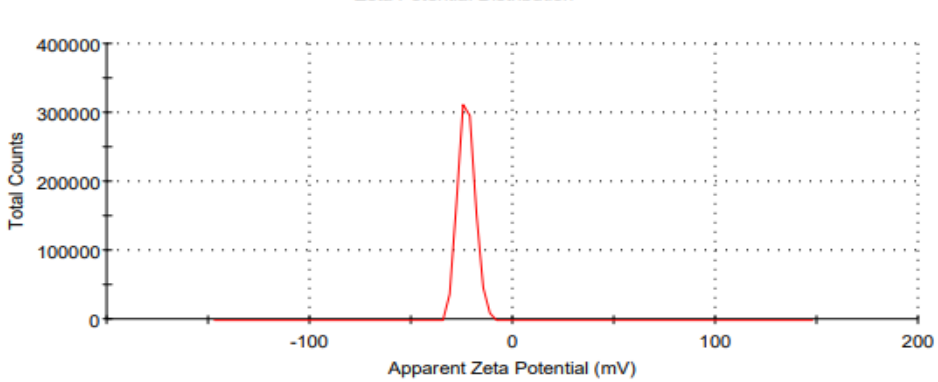
Figure 7. Average zeta potential distribution of the optimized (F5) essential oil loaded nanoemulsion.